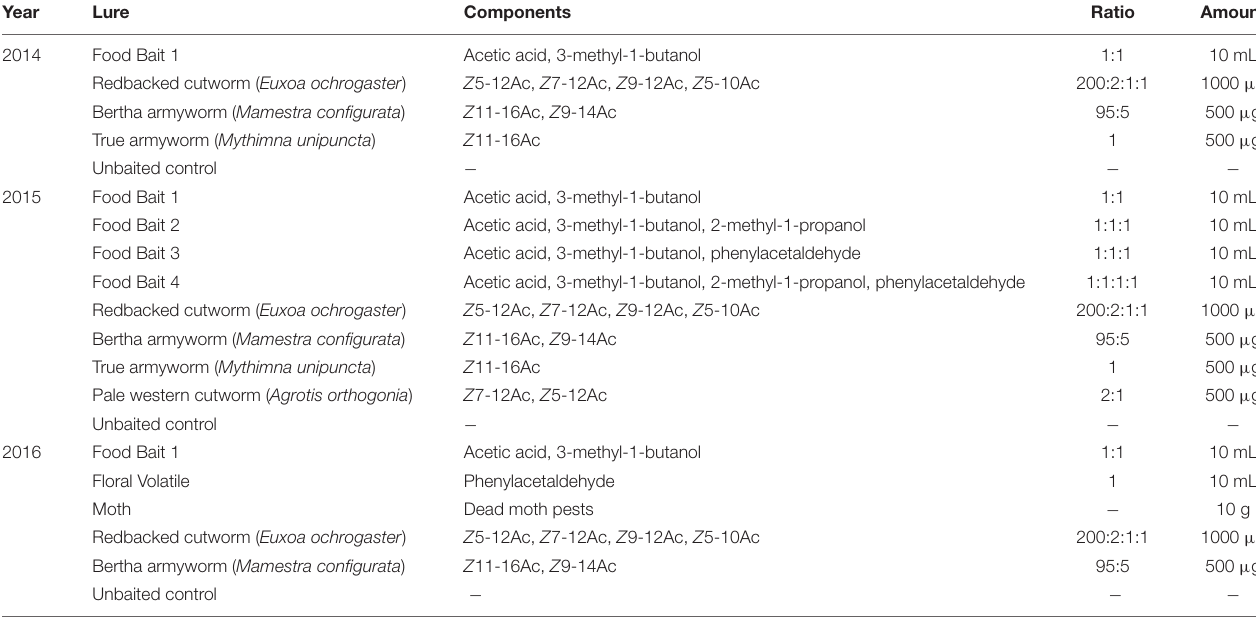
TABLE 1 | Composition of lures deployed in non-saturating green Unitraps in the margin of canola and wheat fields in central Alberta, Canada (2014–2016).